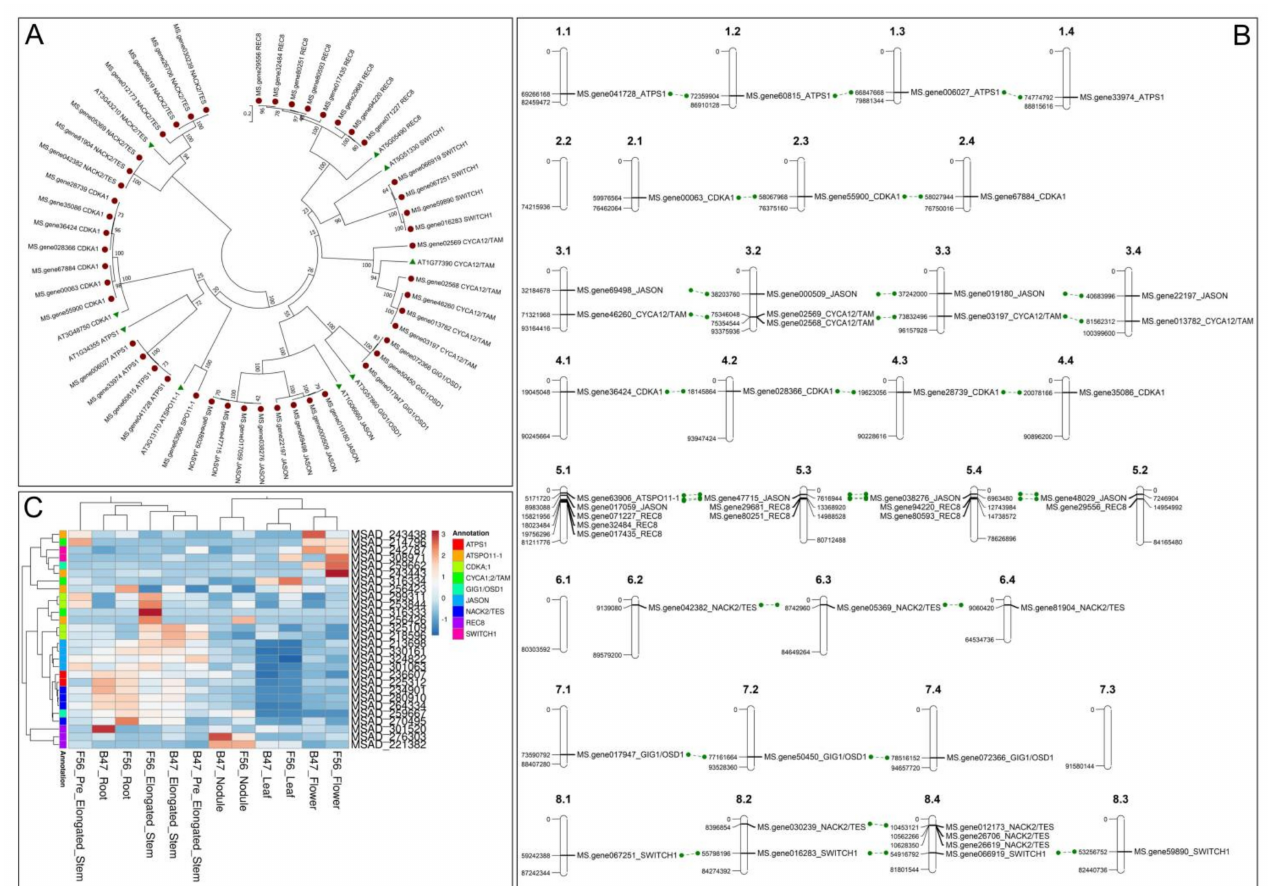
Figure 3. Similarity-based UPGMA analysis performed using 47 amino acid sequences from the M. sativa proteome [91] and selected for their putative orthology (Table 2 and, more specifically, Table S2) with 9 well-characterized proteins belonging to A. thaliana (At) selected for their direct involvement in unreduced male and/or female gamete production ( A ). Distribution of the 47 candidate genes throughout the 8 chromosomes of a tetraploid alfalfa genotype. Green lines connect allele copies of homologous chromosomes ( B ). Taking advantage of a recent gene atlas available for alfalfa [90], the relative abundance levels of 28 transcripts putatively corresponding to the 47 protein sequences mentioned above (BLASTp; http://blast.ncbi.nlm.nih.gov/Blast.cgi, (accessed on 15 March 2021; Table 2 and Table S2) were evaluated in 6 different tissues (roots, root nodules, leaves, flowers, elongating stem internodes, and post-elongation stem internodes) and two genotypes (B47, M. sativa ssp. sativa and F56, M. sativa ssp. falcata ) ( C ). Expression data are available in Table